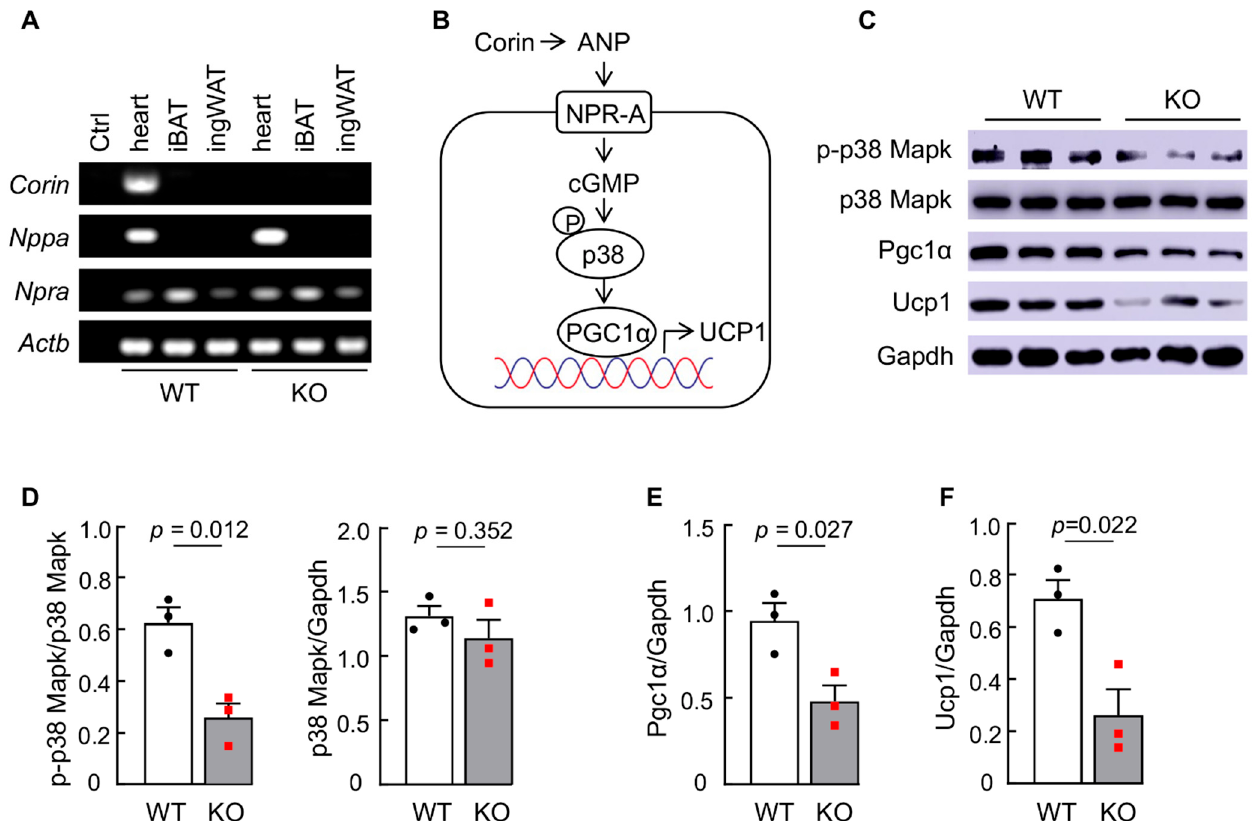
Figure 6. Analysis of the p38 Mapk signaling pathway in iBAT from WT and corin KO mice. ( A ) RT-PCR analysis of Corin , Nppa, and Npra mRNA expression in heart (positive control), iBAT, and